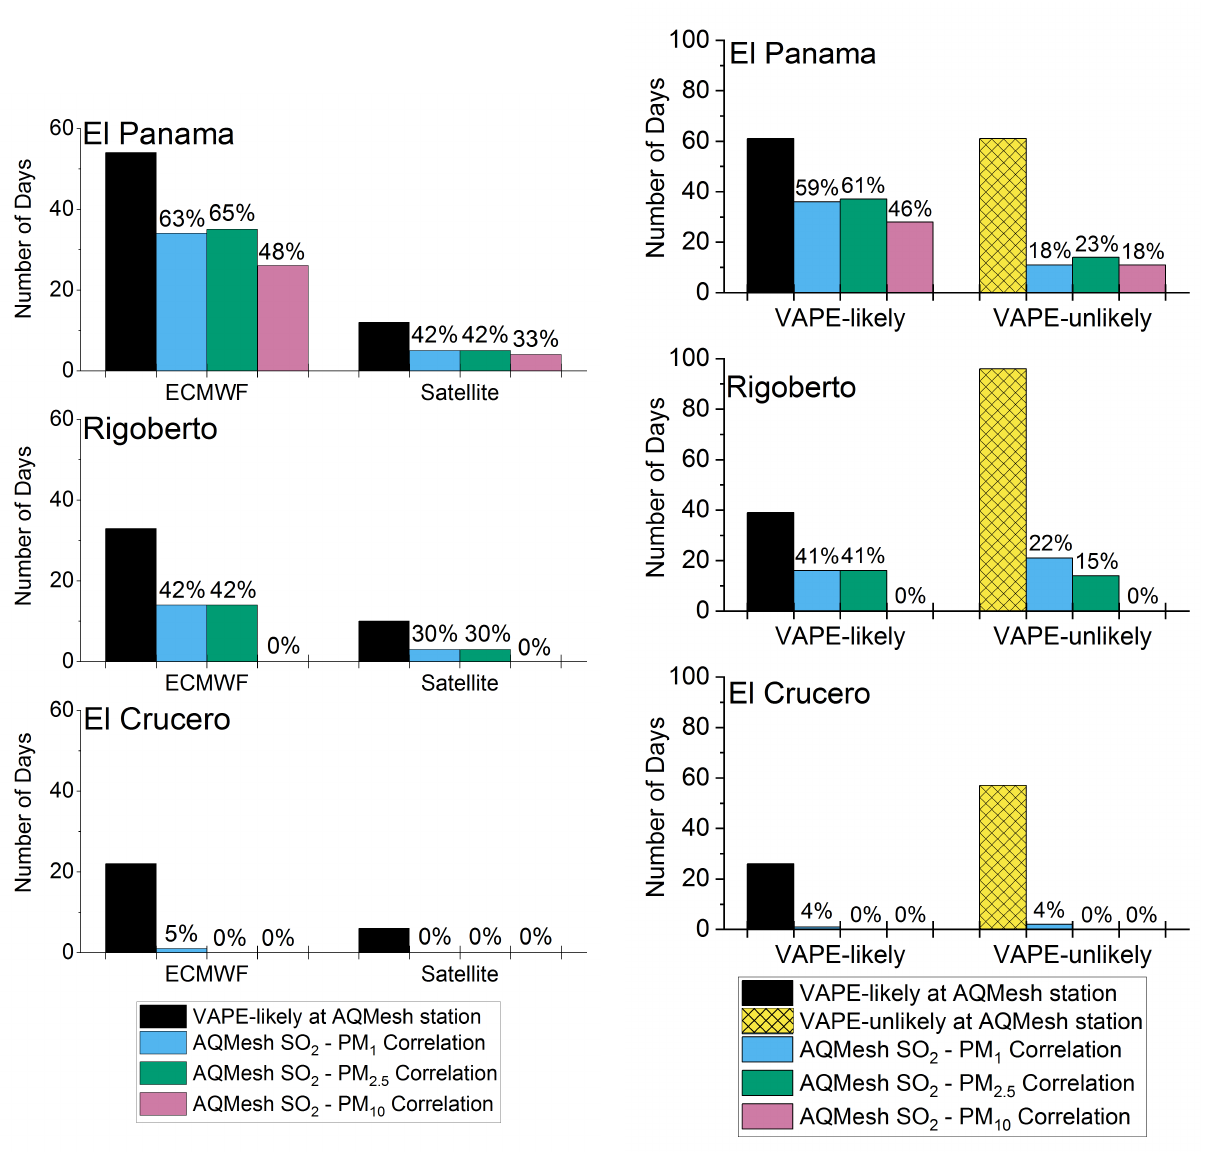
Figure 10: Efficiency of AQMesh pods at recognising Figure 11: Efficiency of AQMesh pods at recognising VAPE derived from satellite and ECMWF data at three VAPE at three measurement stations. Black bars in- measurement stations. The frequency of VAPE-likely dicate frequency of VAPE-likely conditions at the mea- periods at the measurement station is indicated by the surement station, as derived from both ECMWF and black bar, and frequency of simultaneous enhancement satellite data, during periods when the AQMesh pod of SO and PM AQMesh measurements are indicated was fully-functional. Yellow hatched bars indicate fre- 2 by the blue, green and pink bars. Only periods where quency of VAPE-unlikely conditions at the measure- the AQMesh instrument was functional are considered ment station, as derived from both ECMWF and satellite here. Results are split into VAPE-likely periods derived data, during periods when the AQMesh pod was fully- from ECMWF forecasts and from satellite imagery. Per- functional. Percentages noted on each coloured bar centages noted on each coloured bar indicate the pro- under VAPE-likely conditions indicate the proportion of portion of how often that the AQMesh pods recognised how often that the AQMesh pods recognised VAPE by VAPE derived from the relevant meteorological data. means of simultaneous enhancement of SO and PM. 2 San Juan and Pacaya AQMesh stations are not dis- Percentages noted on each coloured bar under VAPE- played as no simultaneous enhancement of SO and PM unlikely conditions indicate the proportion of how often 2 were found at these stations. that the AQMesh pods gave a disagreement-positive re- sult and falsely indicated VAPE. San Juan and Pacaya AQMesh stations are not displayed as no simultaneous enhancement of SO and PM were found at these sta- 2